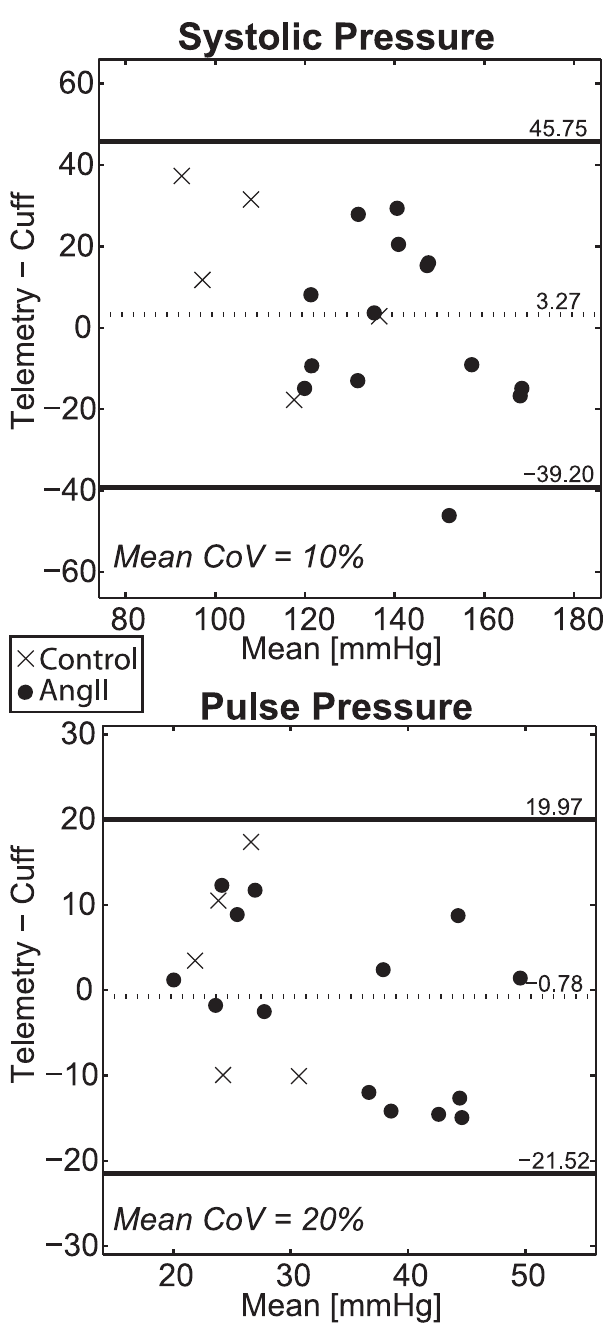
Fig 4. Comparison of Simultaneous Measurements of Implanted Telemetry and Non-Invasive Tail- cuff. Bland-Altman plot comparing telemetry and tail-cuff measurements of systolic (top) and pulse (bottom) blood pressures. Circles denote subjects infused with AngII while ‘ x ’ s denote controls. Overlaid numbers represent the measurement bias (adjacent to the dotted lines) and 95% limits of agreement (adjacent to solid lines). The mean coefficient of variation (CoV) is also